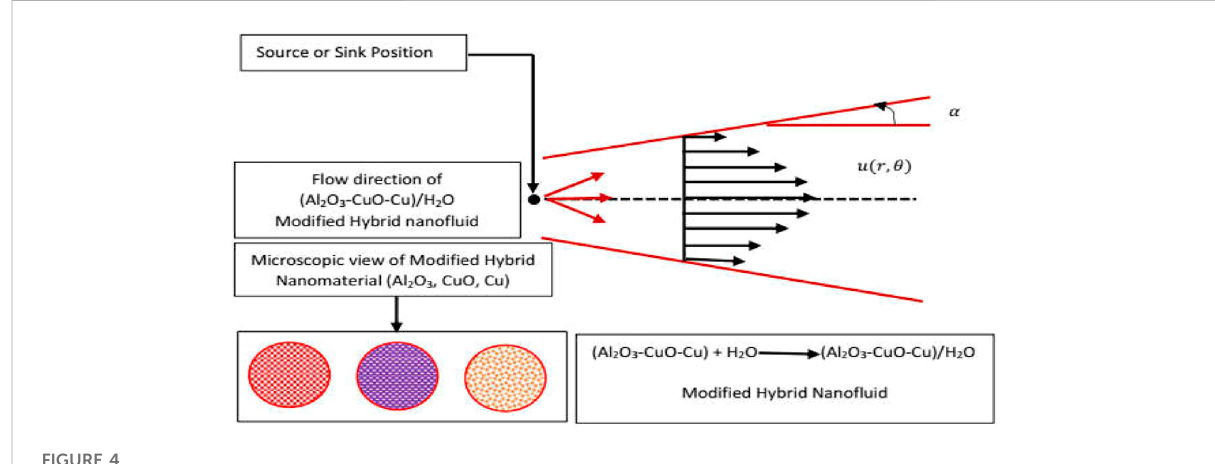
FIGURE 4 Flow scenario of (Al 2 O 3 -CuO-Cu/H 2 O) mhnf .